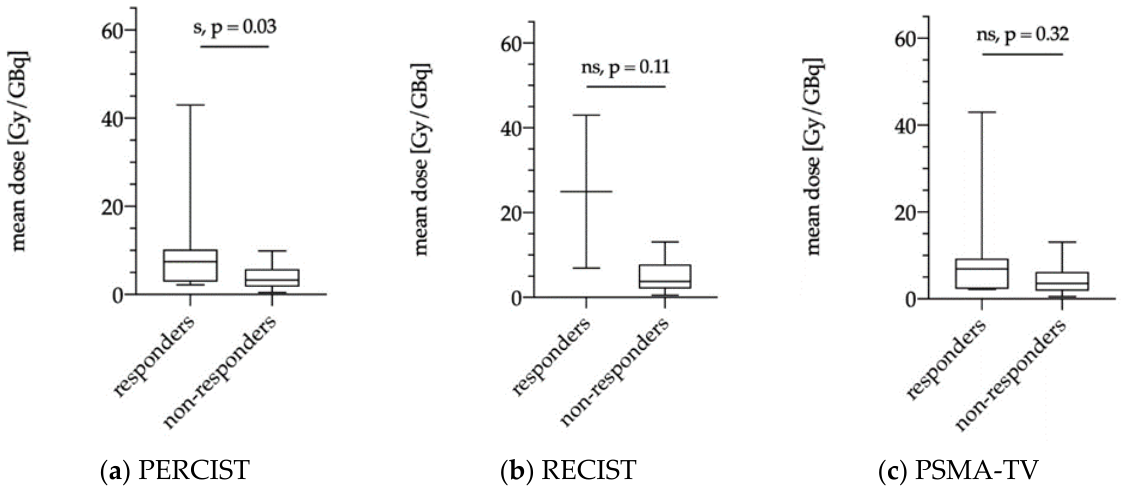
Figure 5. Mean absorbed tumor dose for averaged multiple lesions (“mean dose” in Gy/GBq) stratified according to responders and non-responders using modified PERCIST criteria ( a ), RECIST 1.1 criteria ( b ), and PSMA-TV ( n = 21) ( c ) evaluated. s = significant, ns = not significant.